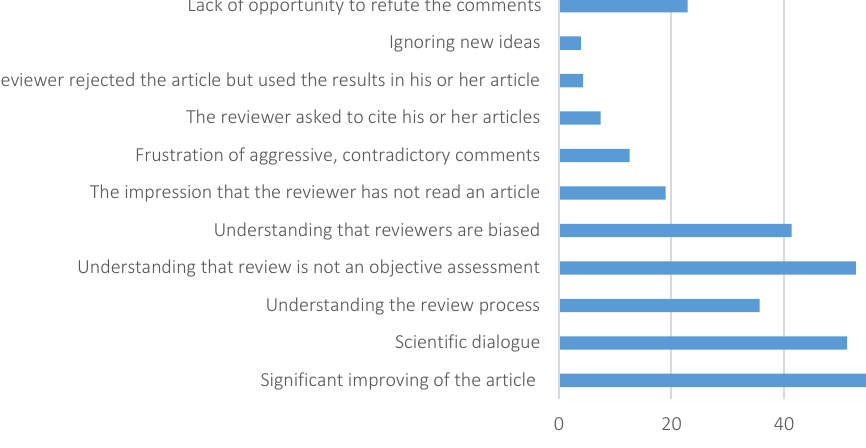
Figure 10. Pros and cons of communication between authors and